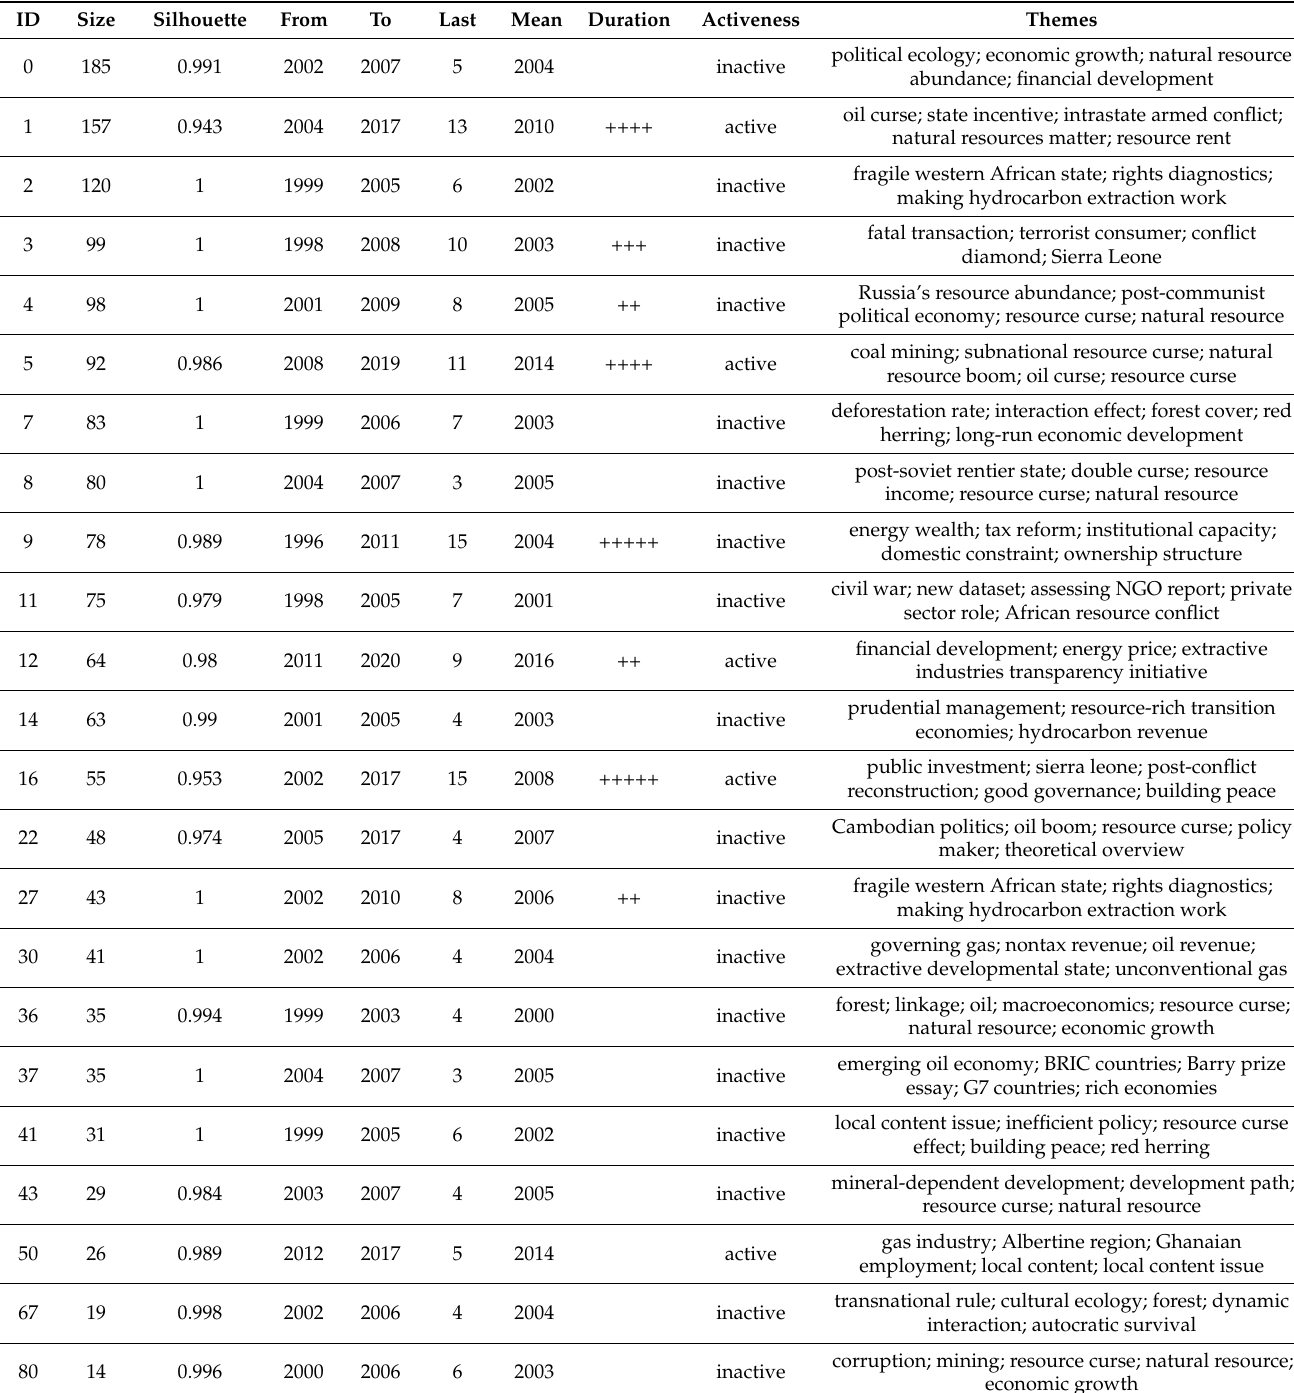
Table 10. Temporal properties of major